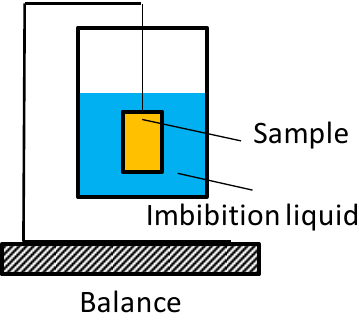
Figure 3. The schematic of the imbibition apparatus